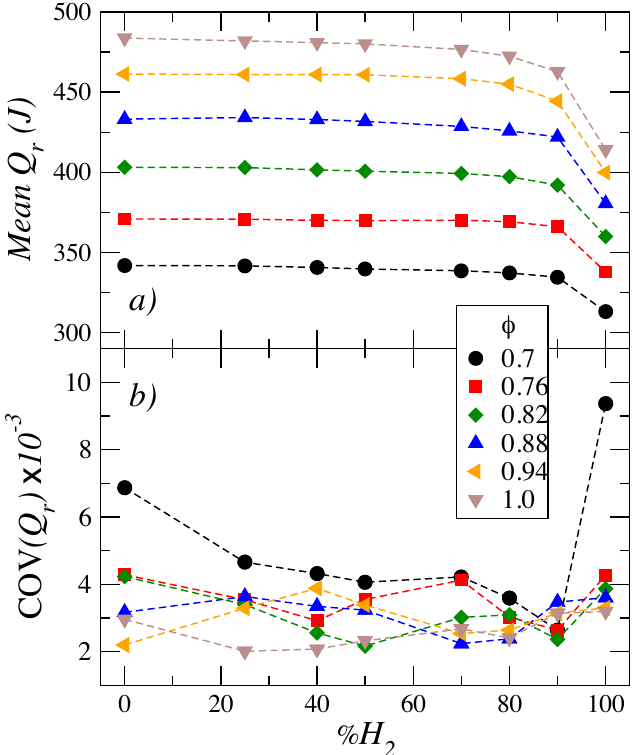
Figure 4. ( a ) Evolution of the mean value of the heat release, Q r , vs. hydrogen concentration, % H 2 , for different fuel–air ratios, φ ; ( b ) Evolution of coefficient of variation (COV) for the same